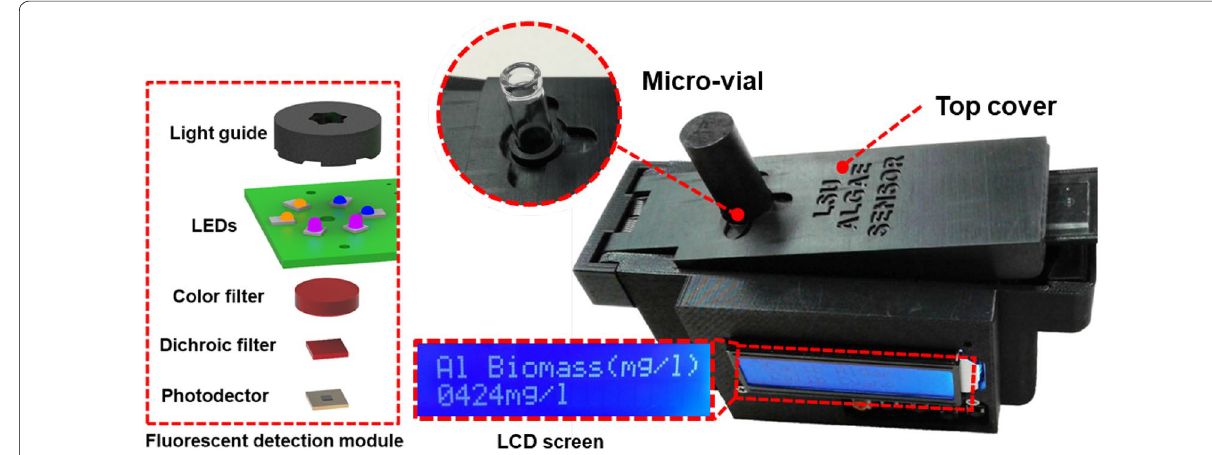
Fig. 2 Developed handheld fluorometer system in